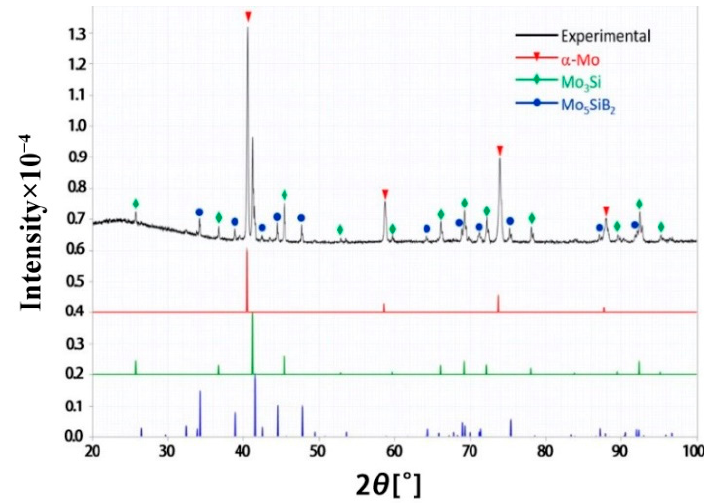
Figure 1. The XRD results of unprocessed Mo-12Si-8.5B alloys.